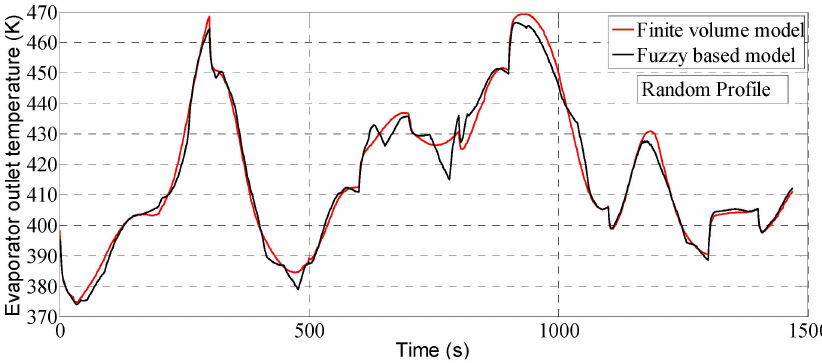
Figure 26. Prediction of evaporator outlet temperature with respect to random